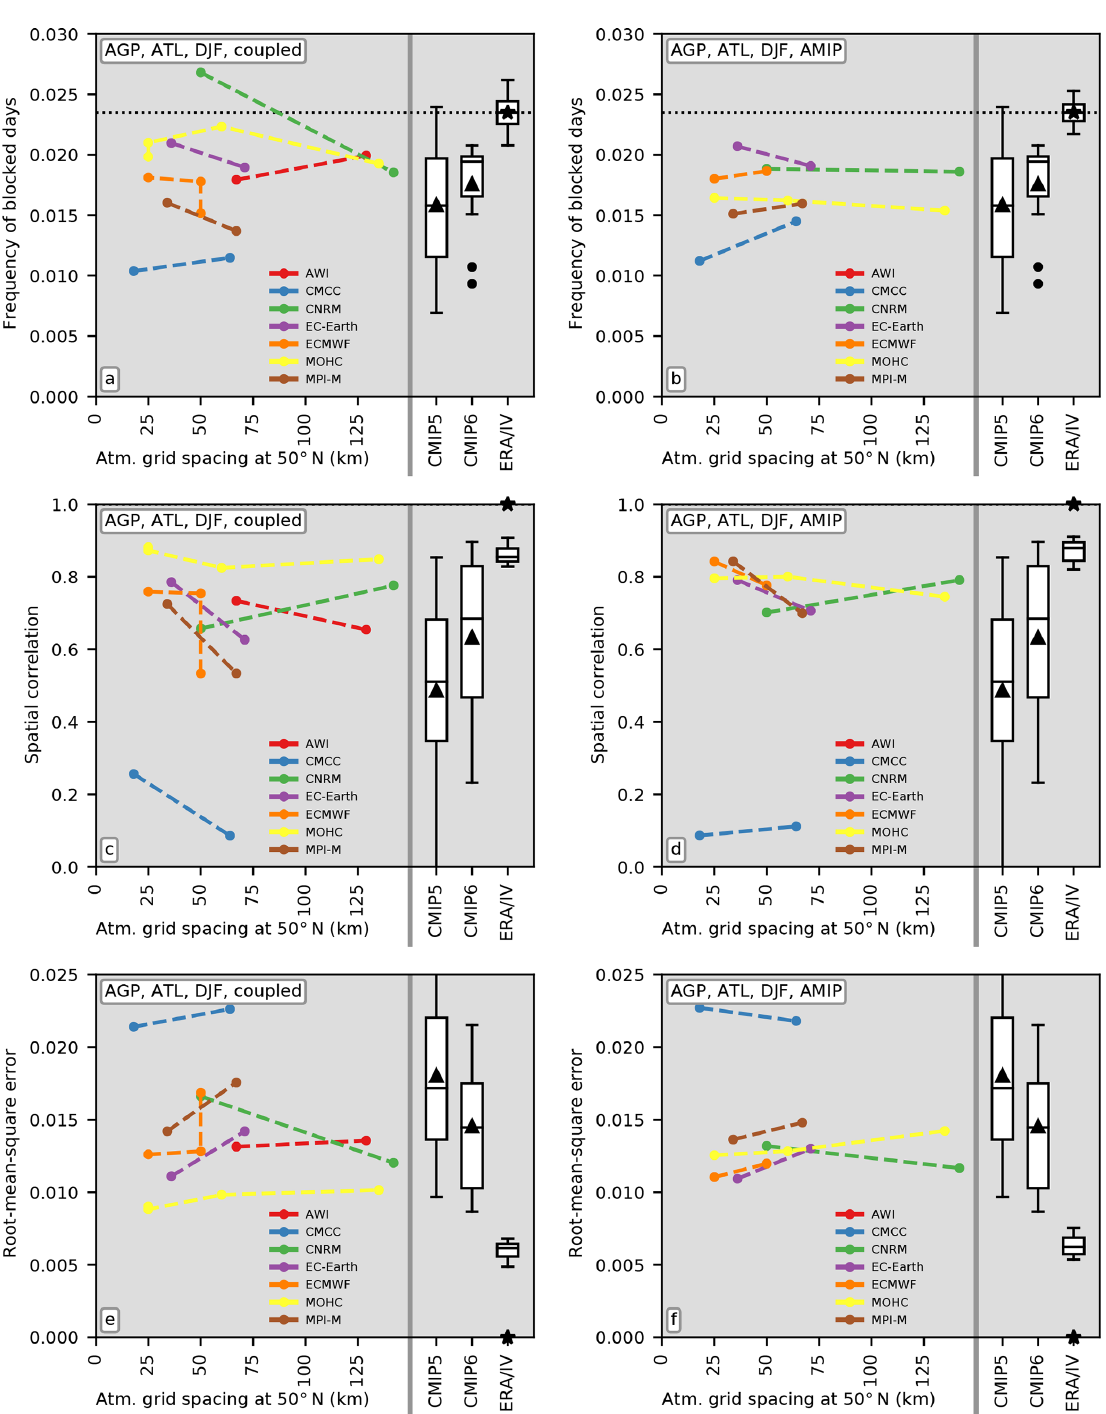
Figure 3. Metrics of blocking performance ( a, b – blocking frequency, c, d – spatial correlation, e, f – root-mean-square error) for the AGP index and boreal winter for the ATL domain (50–75 ◦ N, − 90–90 ◦ E). The left-hand side of each panel shows metrics for PRIMAVERA simulations at different grid spacings (resolutions). Box-and-whisker plots (boxplots hereinafter) on the right-hand side show distributions of the metric across CMIP5 and CMIP6 simulations in terms of the median, mean (triangle), and interquartile range (box, IQR = Q 3 − Q 1), with top whiskers extending to the last datum less than Q 3 + 1 . 5 × IQR and analogously for bottom whiskers. The “ ∗ ” symbol in the column “ERA/IV” shows the reanalysis estimate, and the boxplot is an estimate of the expected agreement given internal variability (see